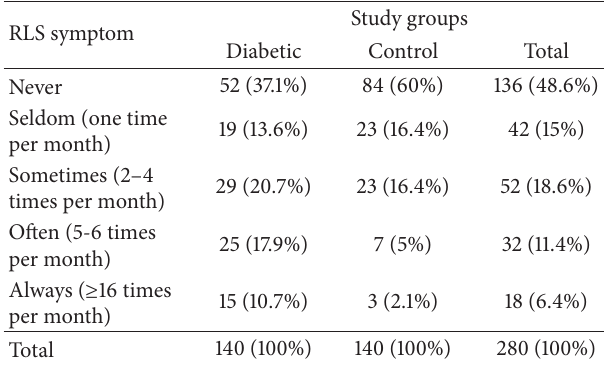
Table 1: RLS frequency in diabetic patients and of the nondiabetic controls.